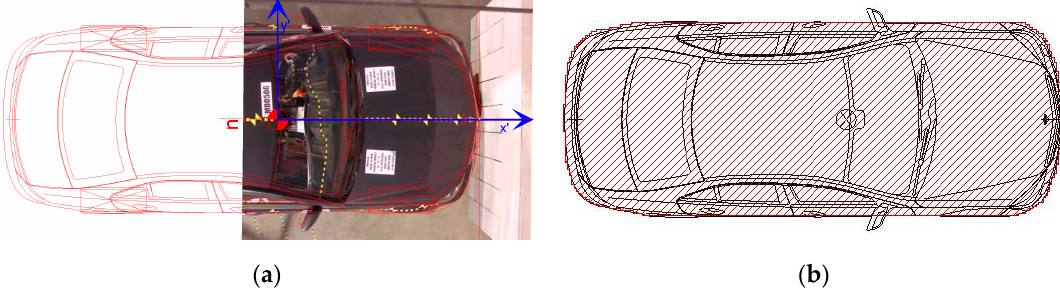
Figure 7. Scaled image of the vehicle with a coordinate system connected with the vehicle ( a ) and rigid area preview on its vector styling projection ( b ).